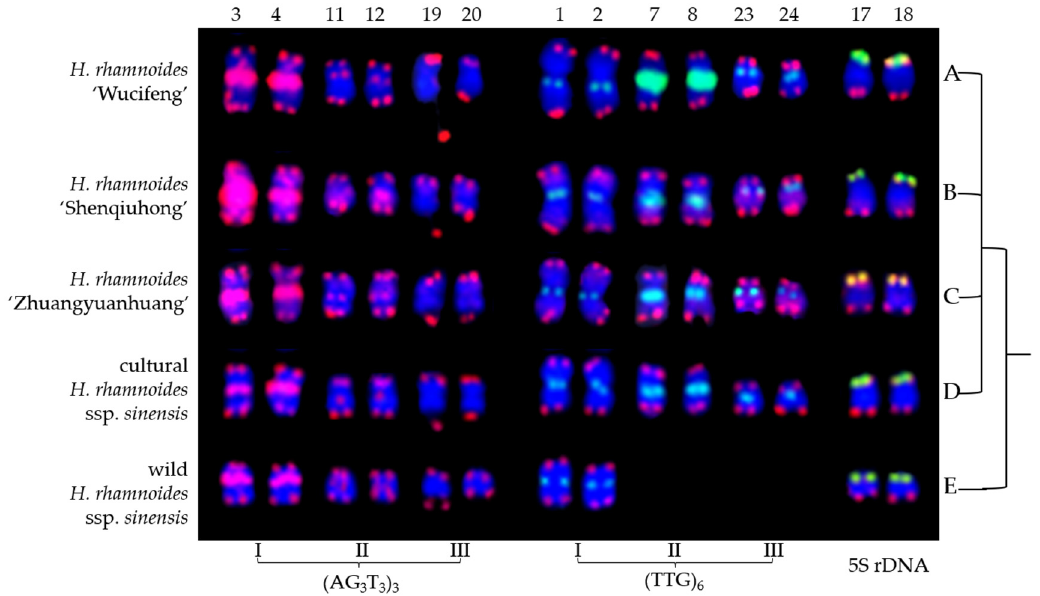
Figure 5. Chromosomes of Hippophaë rhamnoides identified using (AG 3 T 3 ) 3 , (TTG) 6 , and 5S rDNA cut from Figure 3. (A) Hippophaë rhamnoides ‘Wucifeng’, ( B ) H. rhamnoides ‘Shenqiuhong’, ( C ) H. rhamnoides ‘Zhuangyuanhuang’, ( D ) cultural H. rhamnoides ssp. sinensis , and ( E ) wild H. rhamnoides ssp. sinensis .